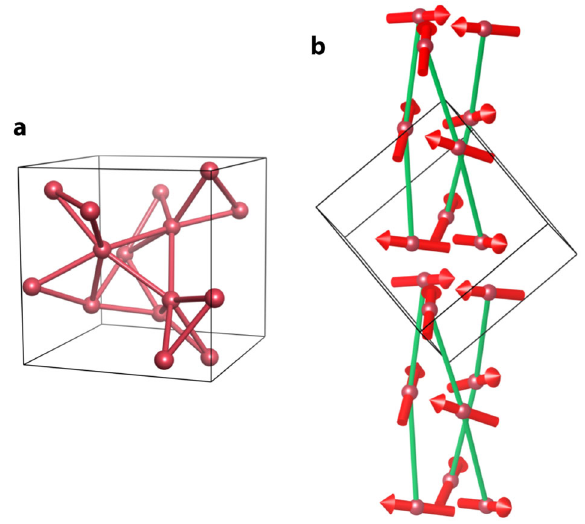
Fig. 1 Magnetic structure. a Hyperkagome network of Mn magnetic sites in the cubic unit cell of Mn 3 RhSi. The 12 b site of P 2 1 3 is preferentially occupied by Mn magnetic moments. b Helical spin rod of triangular units along [111]. Vertical bonds correspond to the J 5 ferromagnetic interaction described in ref. 21